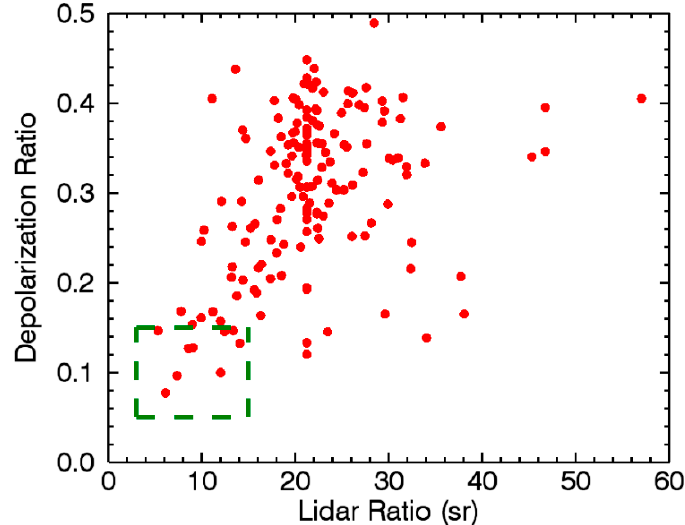
Figure 13. Scatterplot showing the relationship between cirrus depolarization ratio and lidar ratio. Cirrus which may contain horizontally-oriented ice crystals are marked by a green rectangle. Note that the depolarization ratio tends to increase with increasing lidar ratio for the lidar ratio value being less than 30 sr.